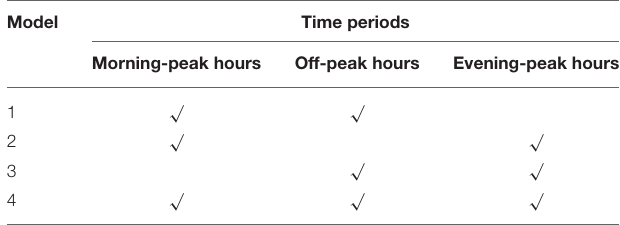
TABLE 1 | Combined MNL models with different time